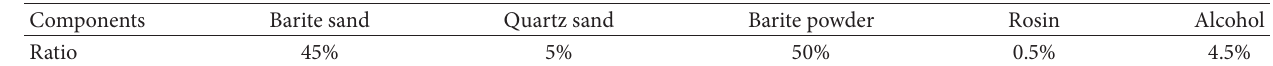
Figure 4: Stress, strain, and temperature sensors measuring points. Table 2: The ratio of equivalent